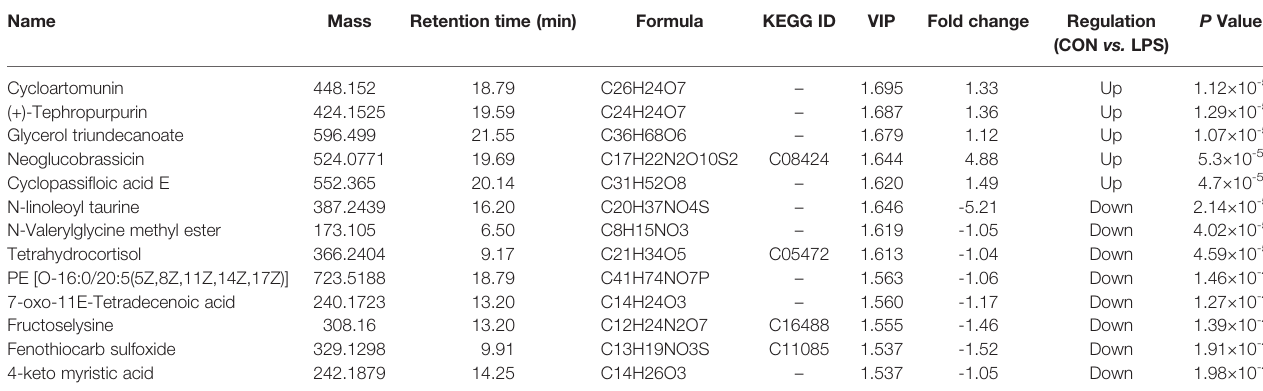
TABLE 1 | Differential metabolites identi fi ed in serum samples of the CON and LPS